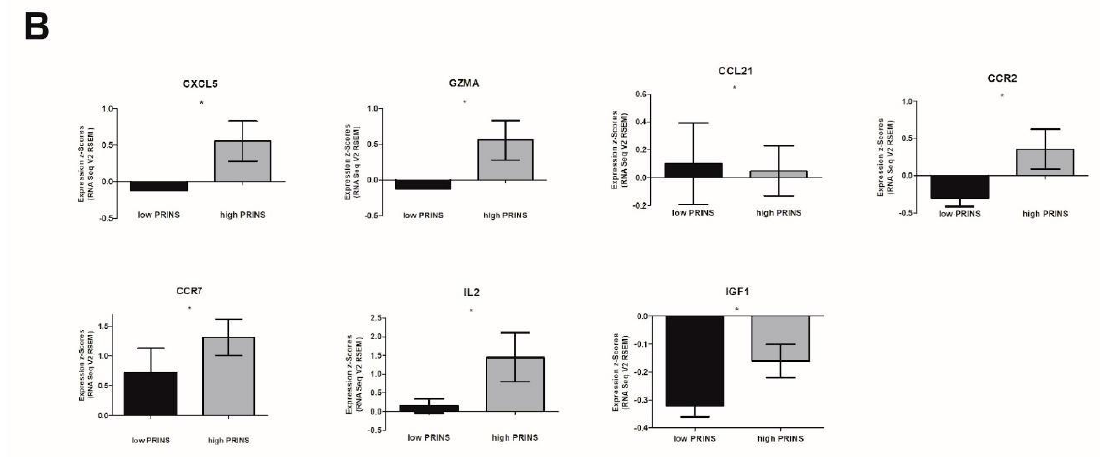
Figure 4. Expression of genes associated with ( A ) antiviral response and ( B ) inflammatory response in HPV( + ) HNSCC patients according to PRINS expression level; un-paired T-test or Mann-Whitney U test. The graphs show median values with SEM. Ns: not significant, * p < 0.05.